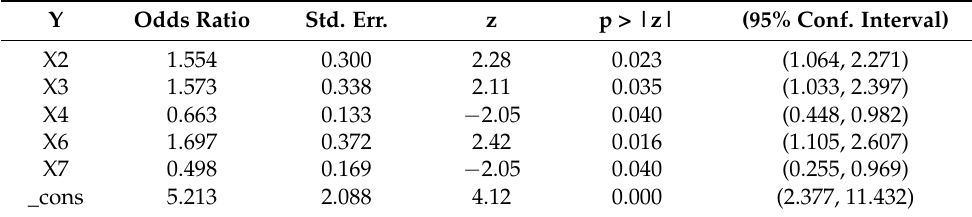
Table A9. The last step of stepwise logistic regression.